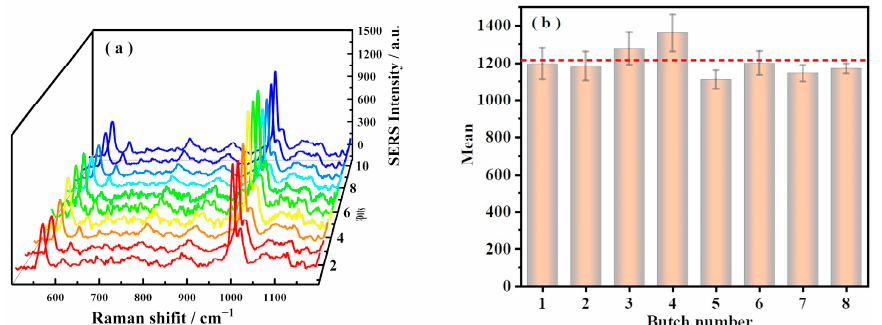
Figure 4. The reproducibility and stability of the FSM SERS method for DM (0.5 ppm) ( a ) Series of DM SERS spectra were collected randomly from 10 sites of the FSM SERS method. ( b ) SERS performance of 8 FSMs. The error bars were obtained from 10 measurements. The dotted line in the figure represents the average value of 8 SLFs. Laser and power: 532 nm with 54 mW. Integration time: 3 s. Objective: 50 ×